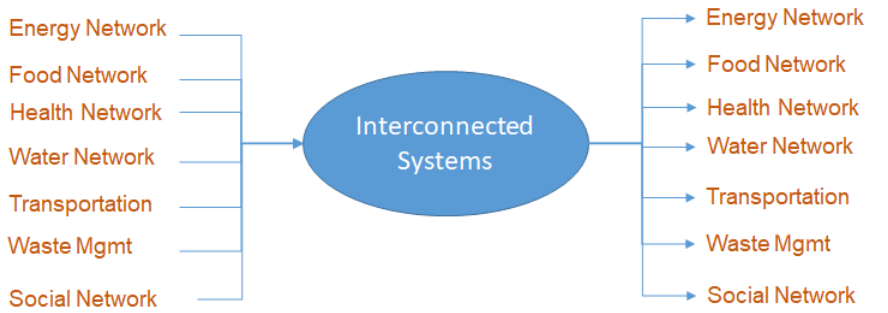
Figure 1. General framework of interconnected systems in smart cities.